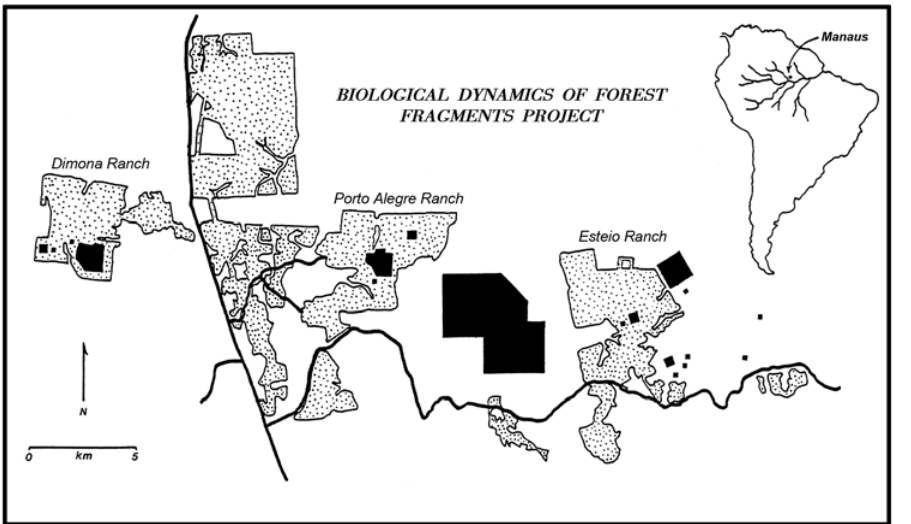
Figure 1. Study area in central Amazonia. Shaded blocks indicate locations of forest fragments and intact-forest controls used in the study. Stippled areas are cattle pastures or regrowth forest, while unstippled areas are intact forest. Thick, solid lines are roads.